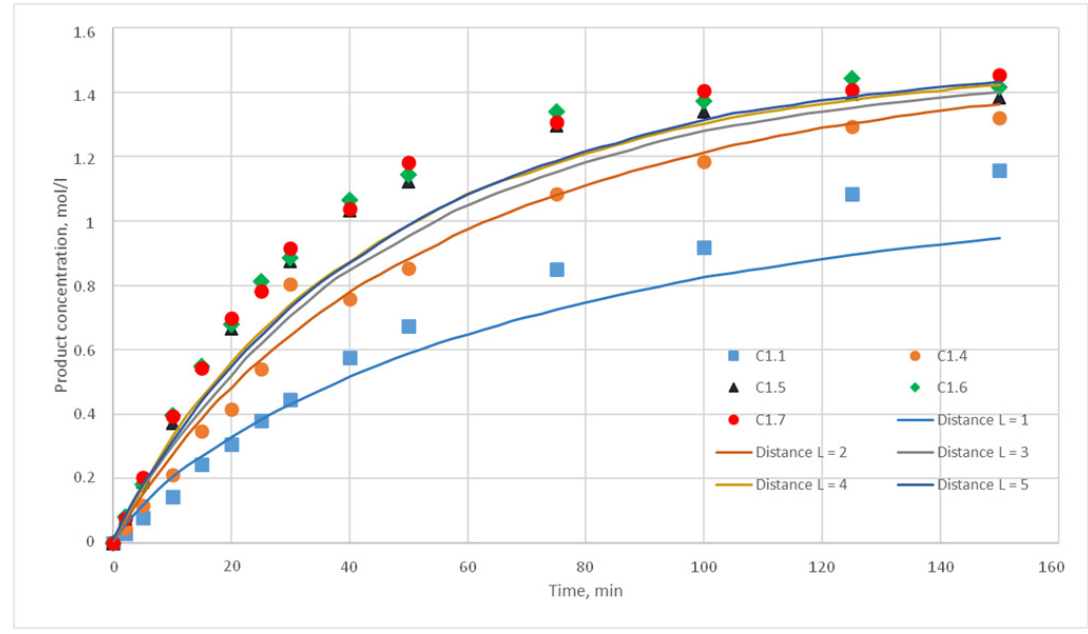
Figure 13. Calculation and experimental reaction kinetic curves. Reaction probability p = 0.015. Lines—calculation curves, points—experimental data.